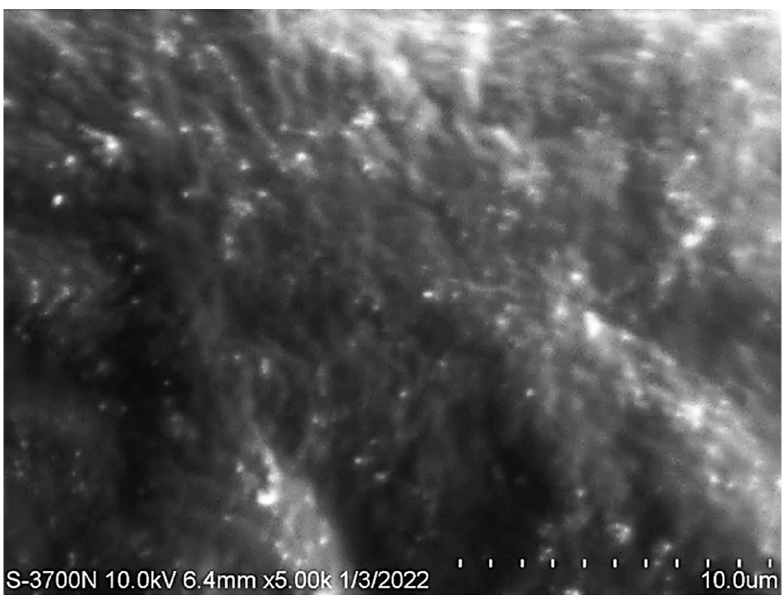
Figure 8. Scanning electron microscopy of the optimized PGZ-loaded NE formulation.